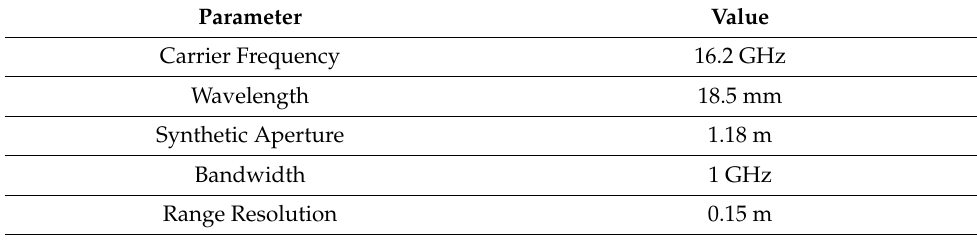
Table 2. System parameters of the GB-MIMO radar.